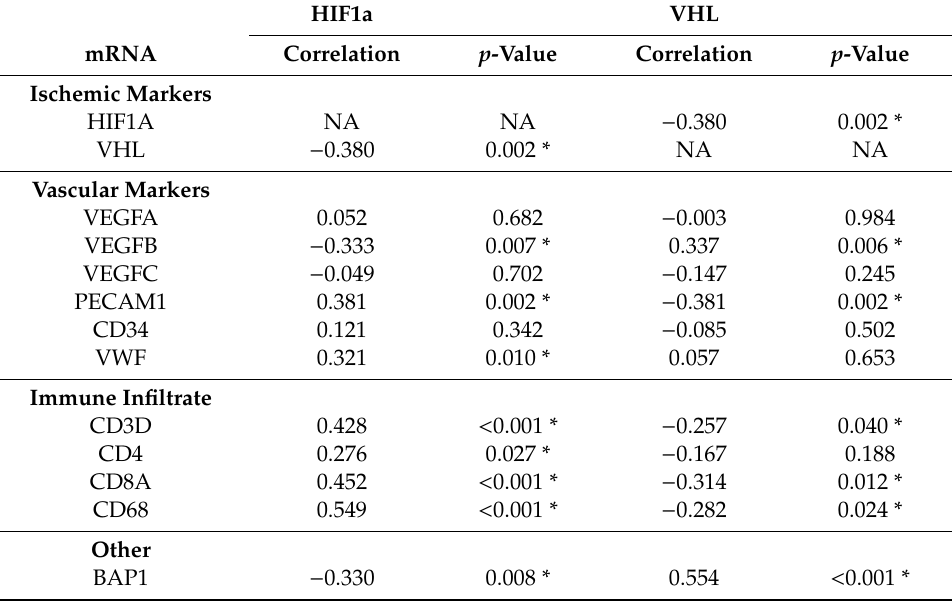
Table 2. Messenger RNA (mRNA) expression of ischemic and vascular markers, and immune infiltrate. The correlation between hypoxia-inducible factor 1-alpha (HIF1a), von Hippel–Lindau (VHL) expression and other genes is shown (based on the n = 64 lesions with data on HIF1a / VHL expression from the Leiden data). HIF1a VHL mRNA Correlation p -Value Correlation p -Value Ischemic Markers HIF1A NA NA − 0.380 0.002